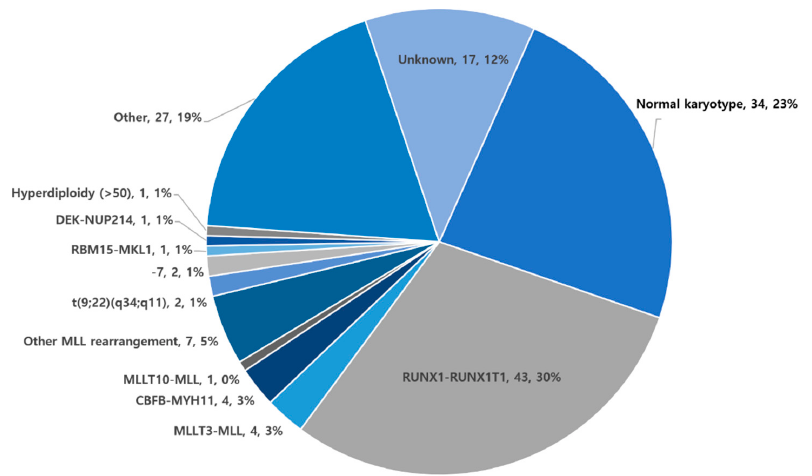
Figure 2. Cytogenetics of patients diagnosed with acute myeloid leukemia. Expressed as cytogenetic anomality, number of patients,